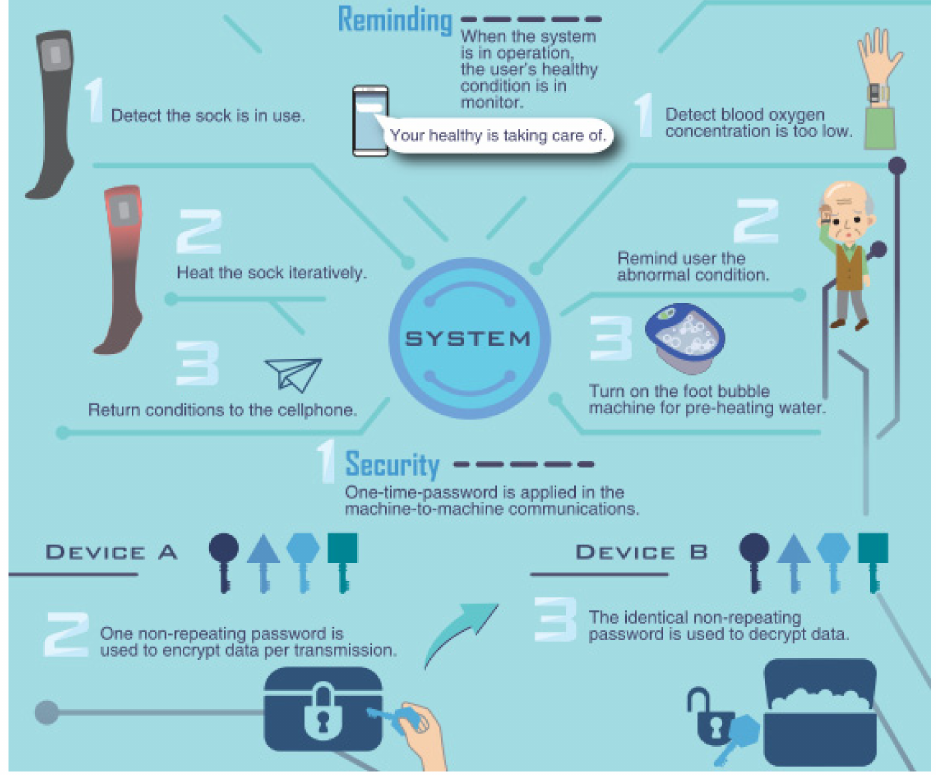
Figure 5. Application scenarios for healthcare IoT devices using D-OTP [36] (Supplementary